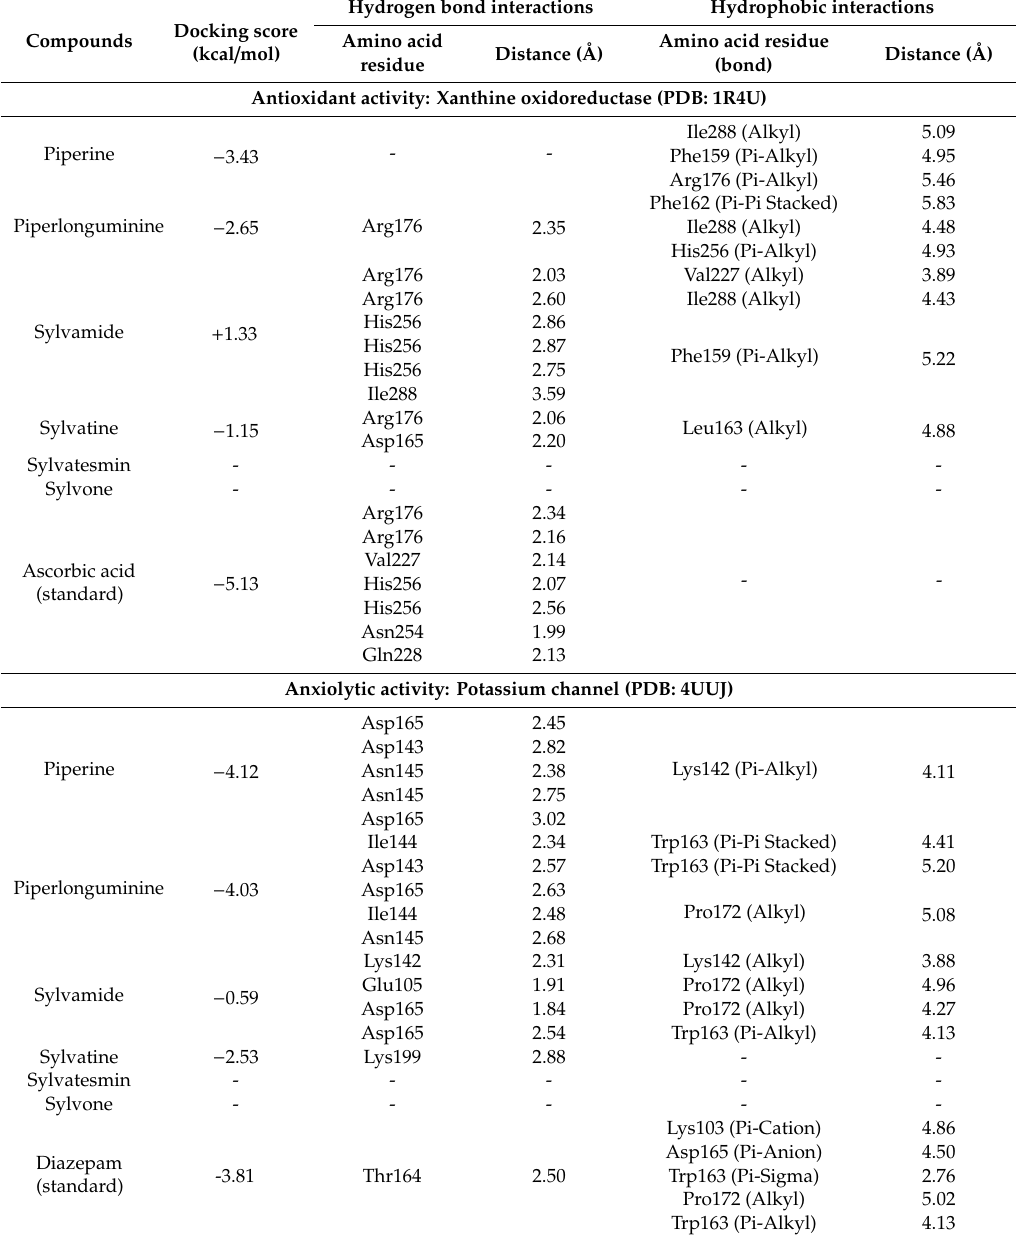
Table 4. Docking scores and binding interactions of the selected compounds with xanthine oxidoreductase (PDB: 1R4U) and potassium channel (PDB: 4UUJ) for antioxidant and anxiolytic activity